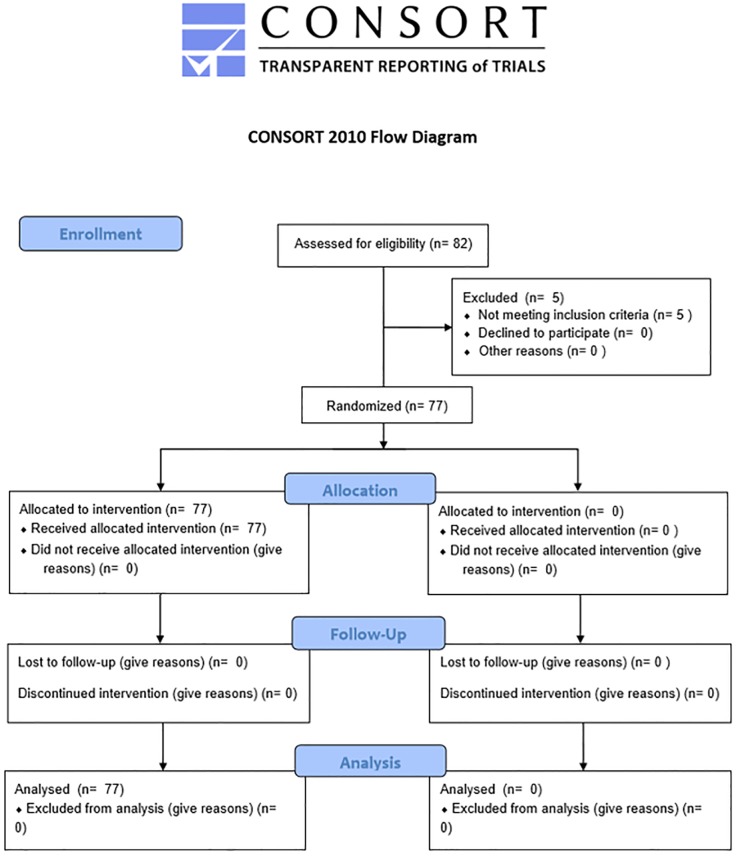
The CONSORT flow diagram.